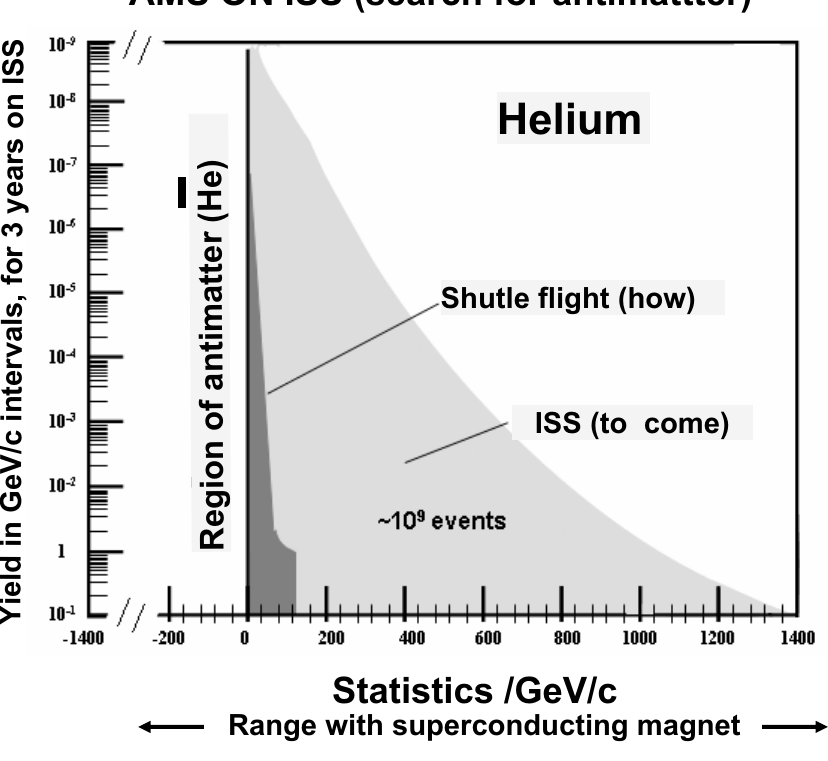
Fig. 4 – The AMS detecting power for antihelium during the Shuttle flight (dark area) and as it will be on the ISS